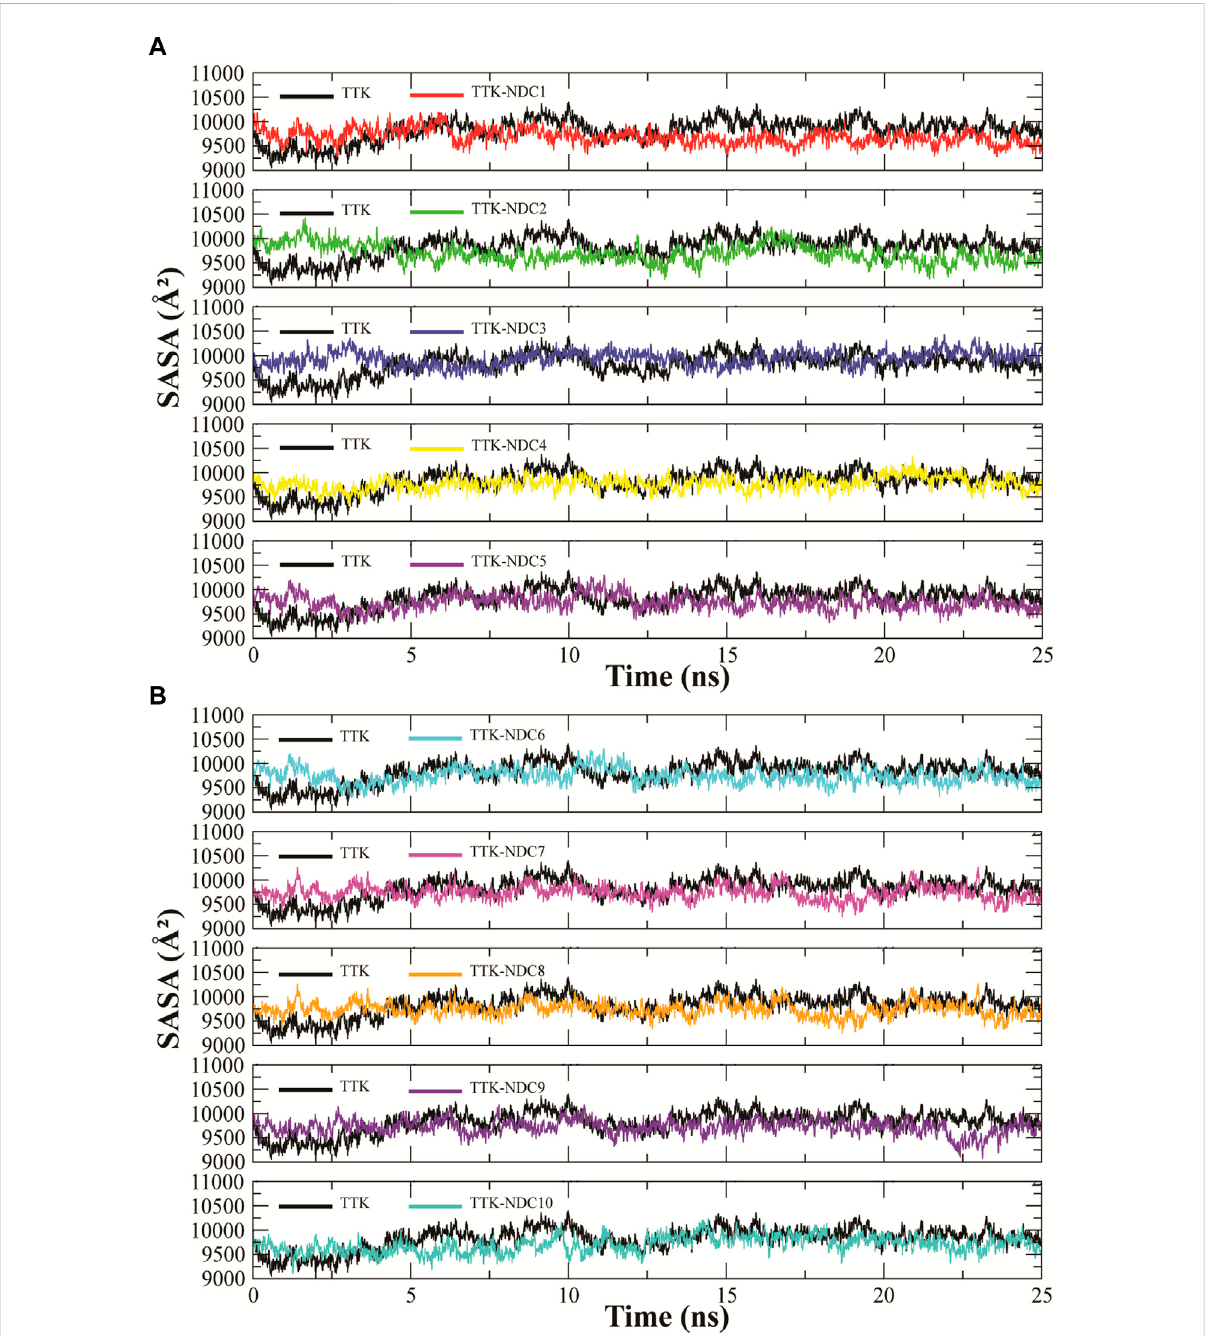
FIGURE 9 (A,B) .Solventaccessiblesurfacearea(SASA)calculationofTTKproteinanditscomplexesthroughoutthesimulationto fi ndtheexposedsurface of protein to solvent during